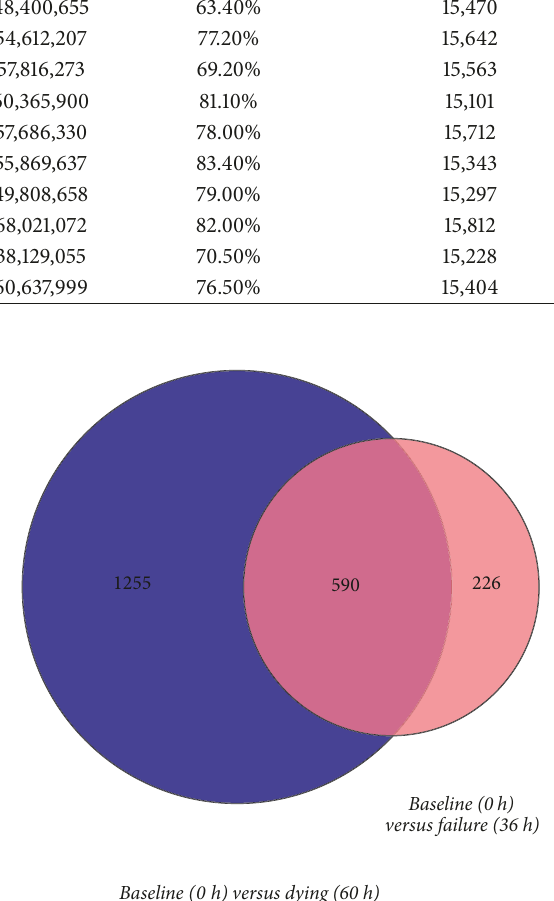
Figure 1: Differential expression of genes involved in the progres- sion of acute liver failure